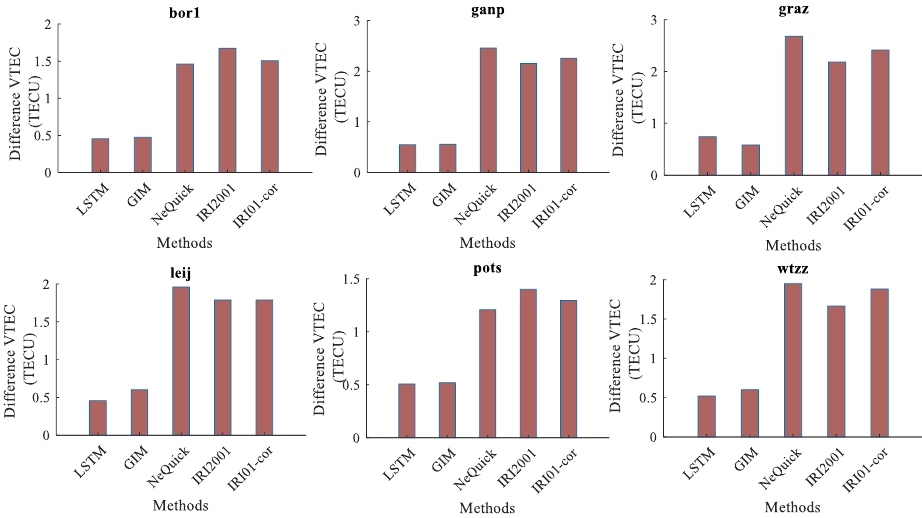
Figure 9. Mean difference between the estimated GPS VTEC values and the VTEC (TECU) LSTM predictions (LSTM), GIM VTEC model values, NeQuick VTEC model values, IRI2001 VTEC model values and IRI01-cor VTEC model